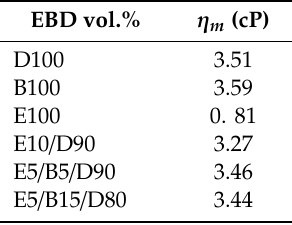
Table 3. Predicted viscosity (at T = 40 °C ) of biodiesel, diesel, ethanol, and their